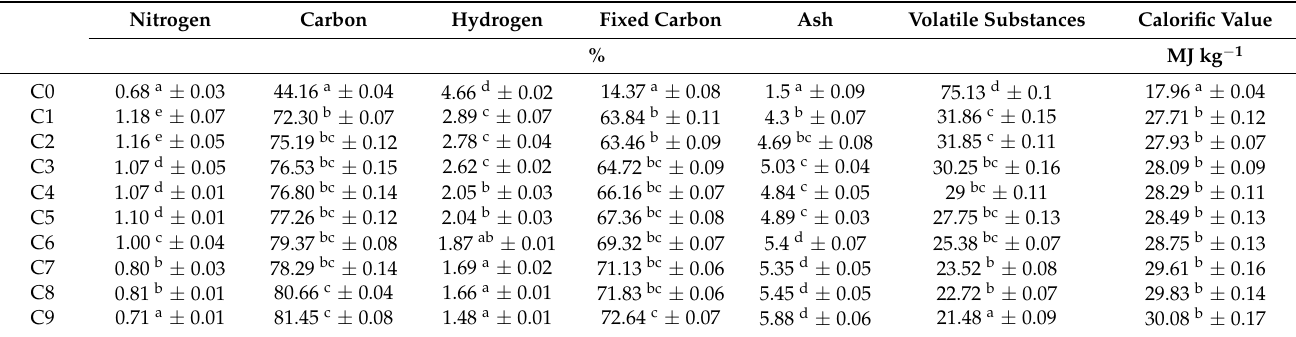
measured in the non-processed material (4.66%), whereas the lowest value (1.48%) was found in the case of the material processed at the highest temperature and with the longest residence time. Table 4. Contents of total nitrogen, total carbon, hydrogen, fixed carbon, ash, volatile substances, and calorific value in non-processed biomass of cherry branches and in the biochars produced.